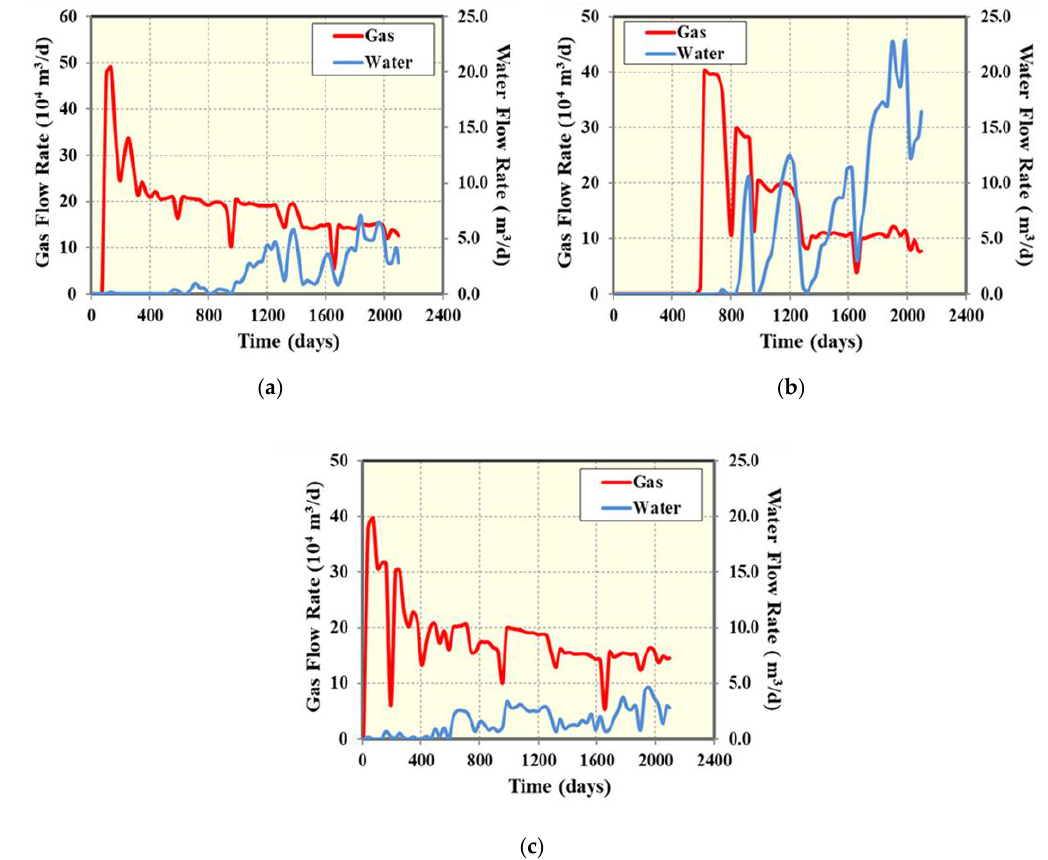
Figure 19. Actual field production rates of well with water production: ( a ) Field gas and water production rates of well B2; ( b ) Field gas and water production rates of well B3; ( c ) Field gas and water production rates of well B5.